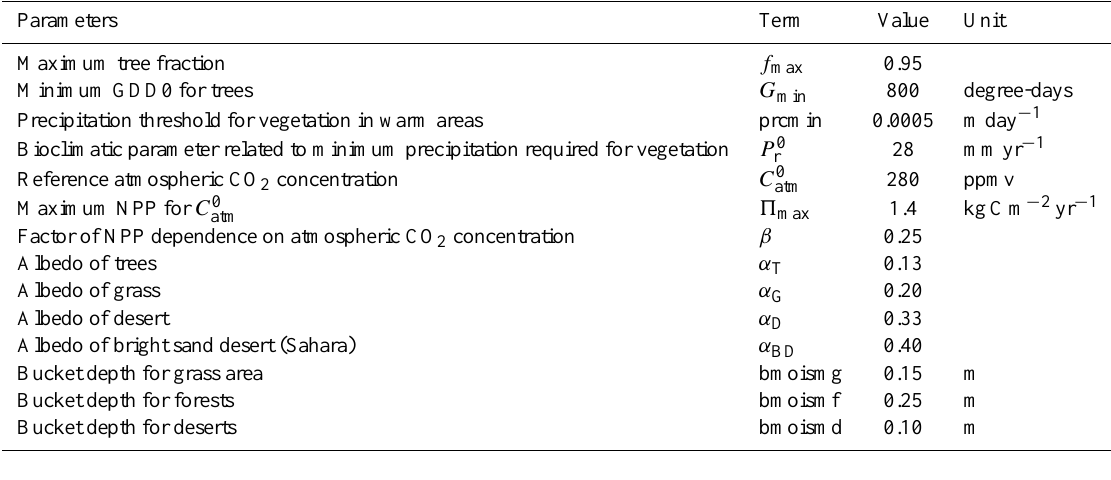
Table 3. Major parameters of VECODE.